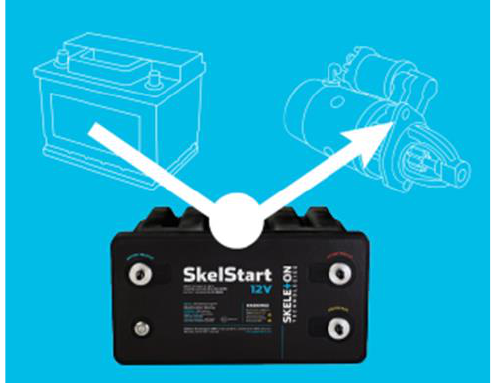
Figure 8. SkelStart module installation [48].